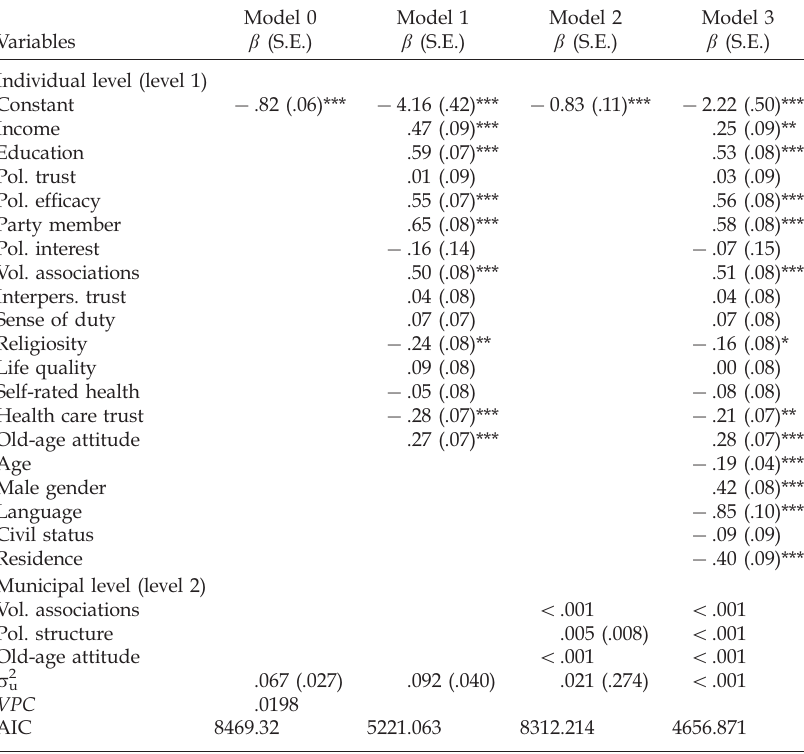
Table 5. The effect of indi v idual- and municipal-le v el v ariables on influencing Model 0 Model 1 Model 2 Model 3 Variables b (S.E.) b (S.E.) b (S.E.) b